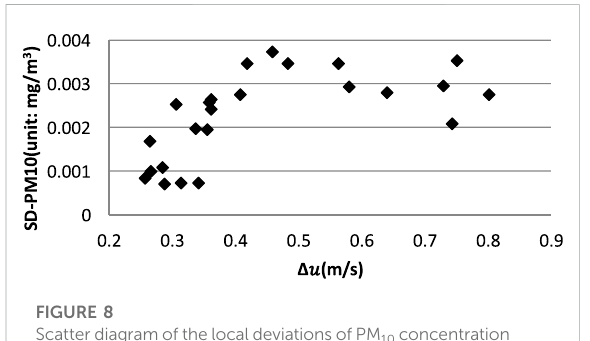
FIGURE 8 Scatter diagram ofthelocal deviations ofPM 10 concentration (SD-PM 10 ) and the local deviated wind ( Δ u